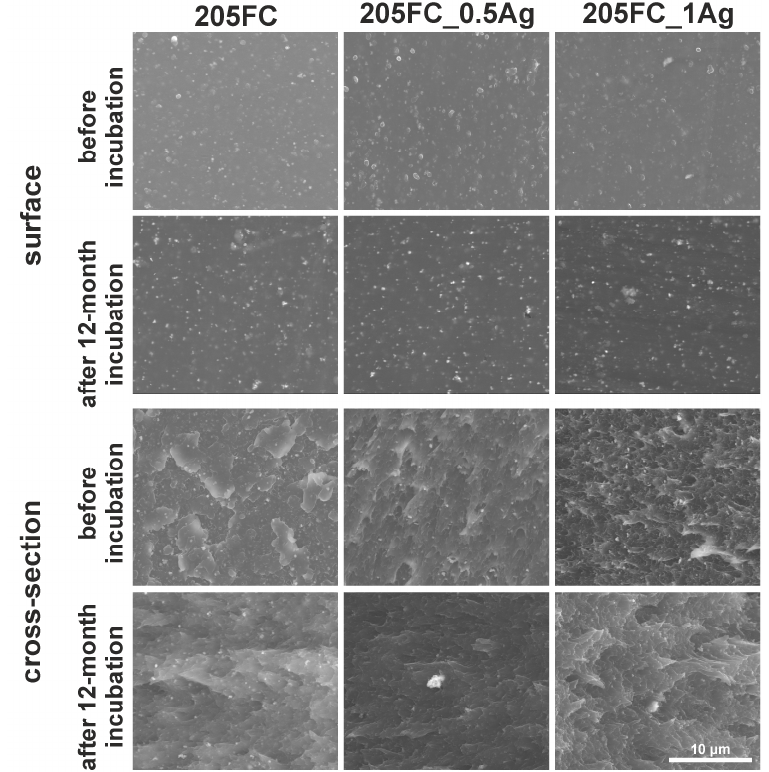
Figure 1. SEM images of surface and cross-section of the 205FC-based materials before and after 12-month incubation in deionized water.